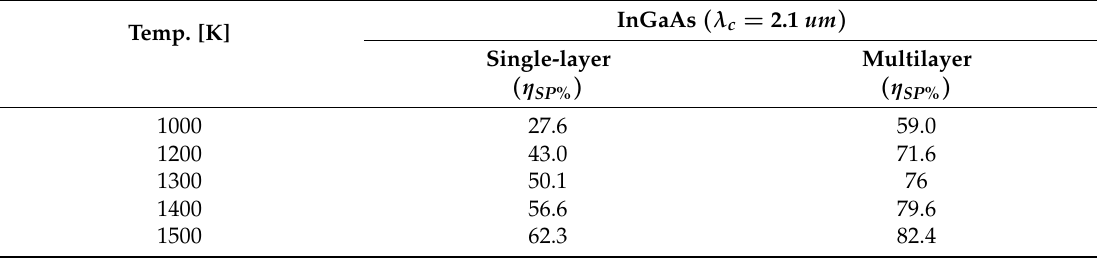
Table 1. Spectral efficiency of single-layer and